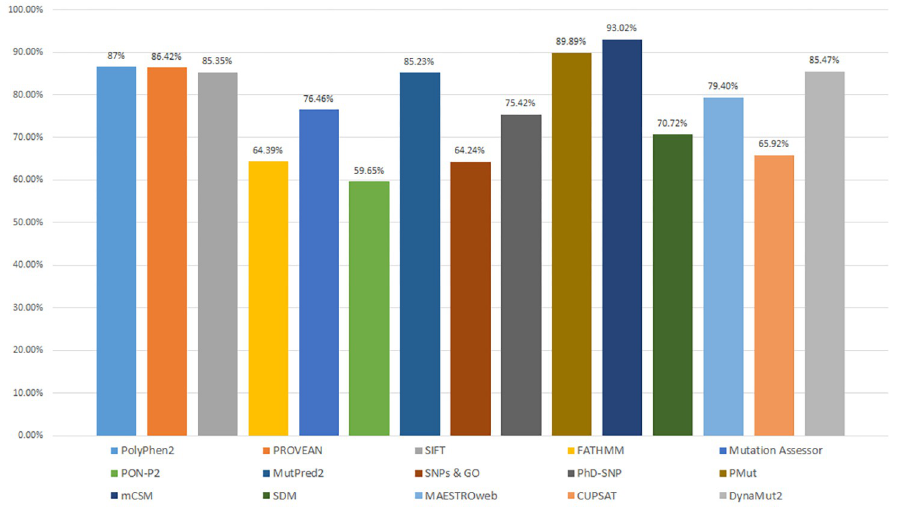
Fig 2. Distribution of average deleterious/destabilizing single amino acid substitutions predicted by all fifteen tools for PARK7, PARK7, PESN1, HRAS and